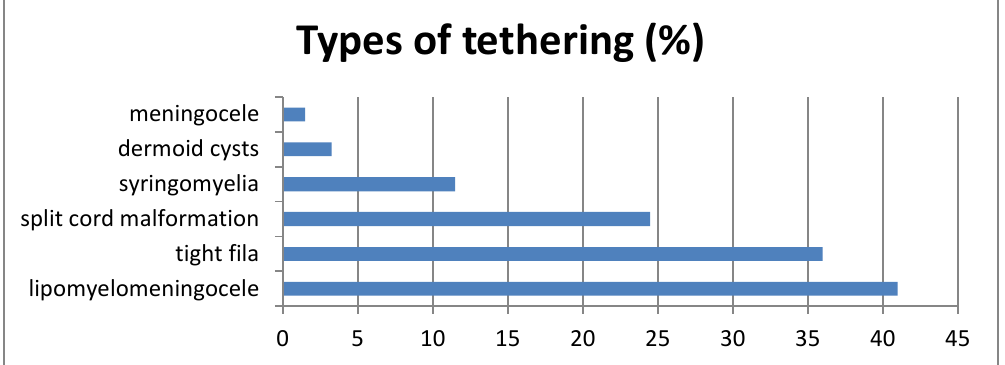
FIG. 1. Bar graph demonstrating the percentages of adult patients with various spinal anomalies noted